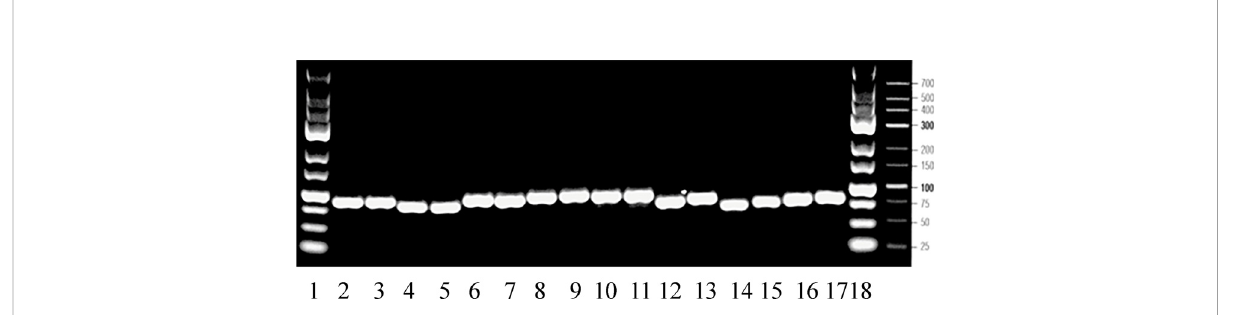
FIGURE 1 Gel electrophoresis of real-time PCR ampli fi cation products at their expected sizes between 75-97 bps (compare Table 1). Lane 1: 25 bp molecular weight marker, lanes 2-3: actb , lanes 4-5: rna18s , lanes 6-7: igf1 , lanes 8-9: igf2 , lanes 10-11: ghr1 , lanes 12-13: gh , lanes 14-15: prl , lanes 16-17: tnf a, lane 18: 25 bp molecular weight